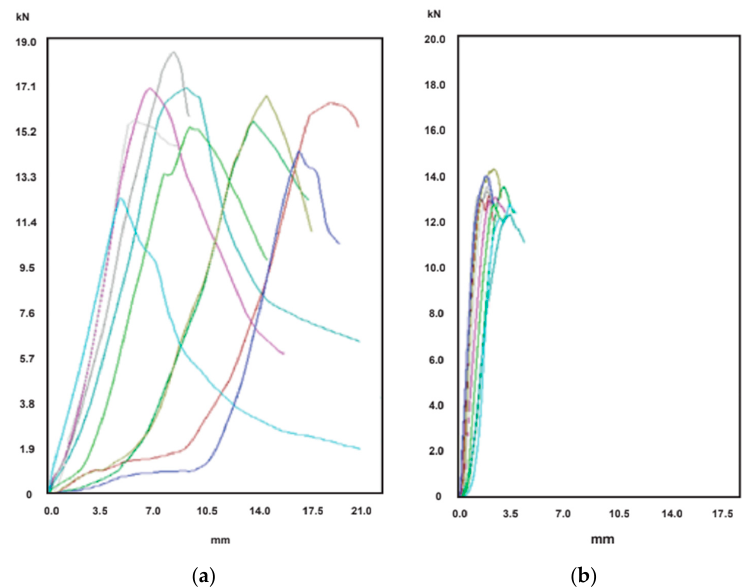
Figure 4. Force-displacement curves of the tests of the item O-05: ( a ) BCT test curves; ( b ) ECT test curves.